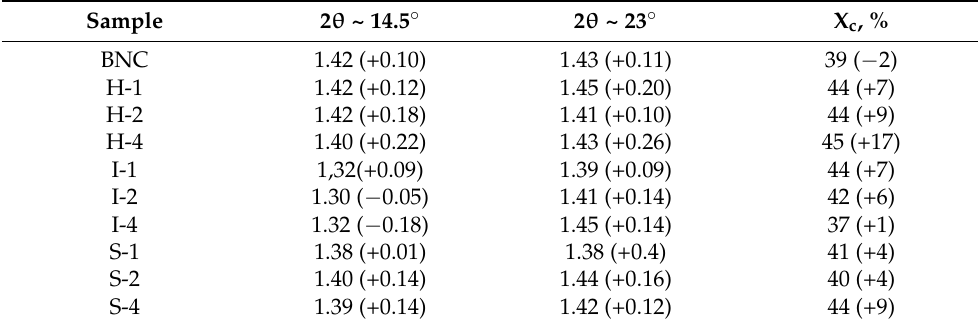
Table 1. The full width at half maximum (FWHM, ◦ ) of XRD signals and degree of crystallinity (X c , %) of UV-irradiated BNC and BNC/PVA blends. The difference between the values in relation to the non-irradiated samples is given in brackets 1